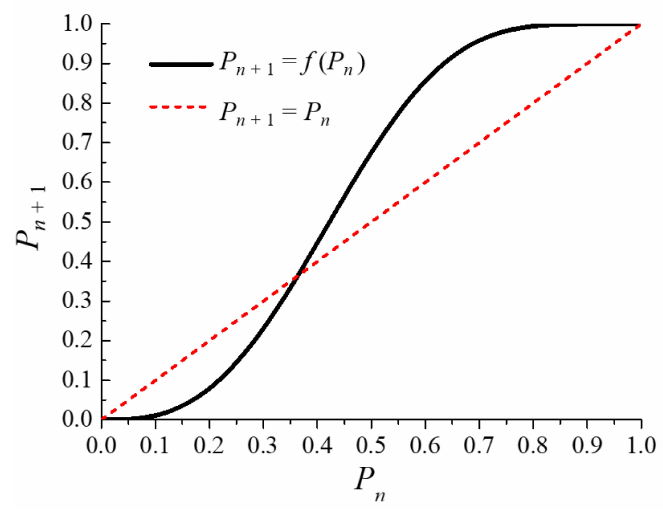
Figure 6. The fixed point of renormalization transformation in soft rock